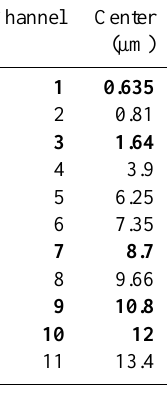
Table 1. SEVIRI channels with the center, minimum, and maxi- mum wavelengths; the channels used in the SEVIRI algorithm are highlighted in bold. Channel Center Min Max (µm) (µm)